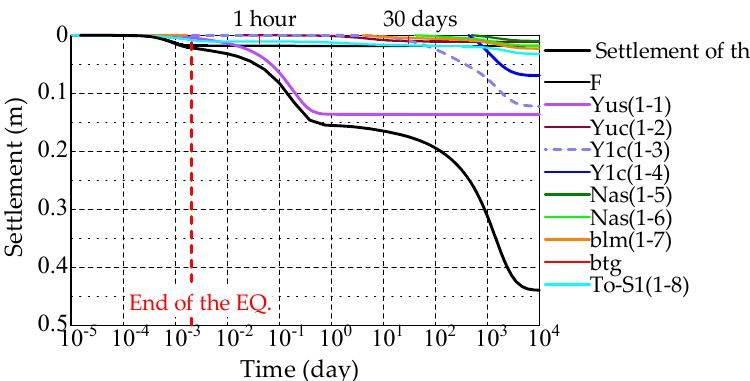
Figure 11. Settlement behavior during and after earthquake: seismic motion (A).